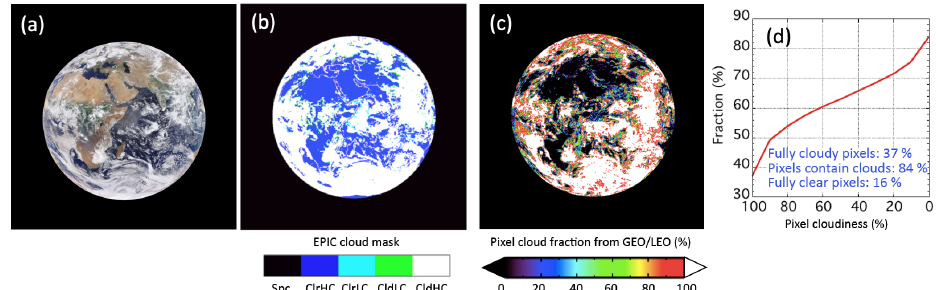
Figure 6. Comparison of the EPIC cloud mask with the co-located GEO–LEO satellite results. (a) The EPIC RGB image for 08:00UTC on 15 September 2015, (b) the corresponding EPIC cloud mask, (c) the corresponding GEO–LEO composite for the sub-pixel cloud fraction of each EPIC pixel, and (d) the cumulative distribution of pixels from 100% cloudy to fully clear for this granule based on the GEO–LEO composite in (c)